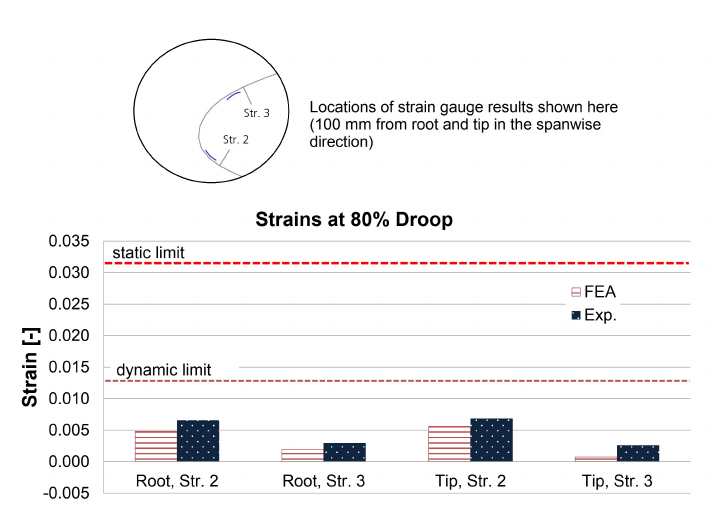
Figure 19. Maximum measured strains from strain gauges and corresponding results from finite element